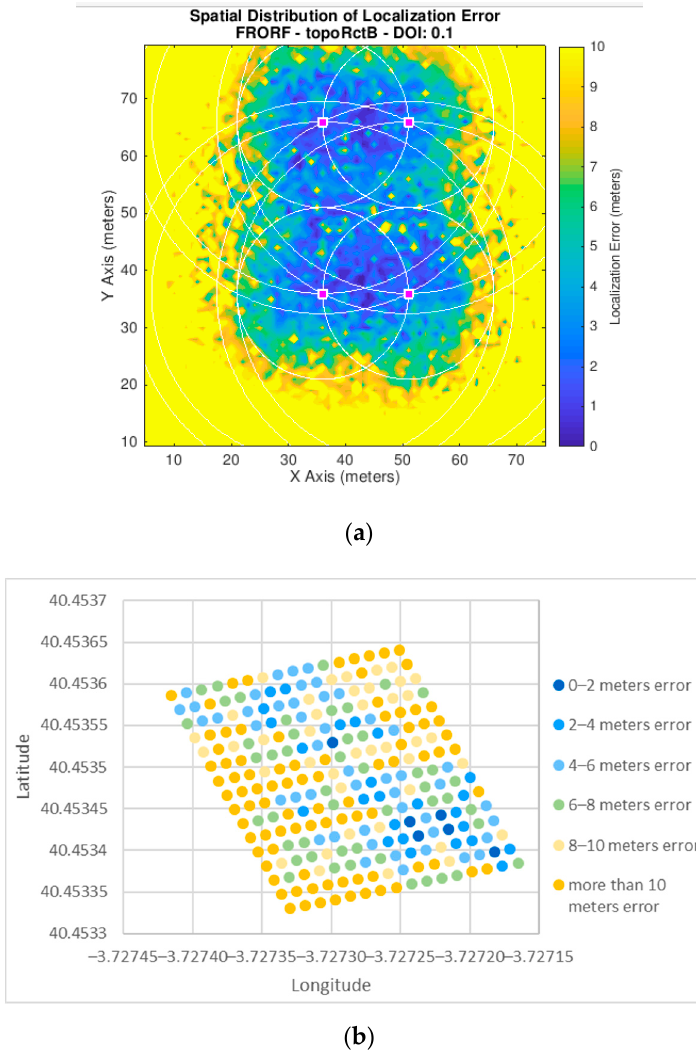
Figure 20. Experiments mean error results for scenario 2. ( a ) Scenario 2 in the simulator ( p -value = 0.5); ( b ) scenario 2 in the outdoor set-up ( p -value = 0.5).